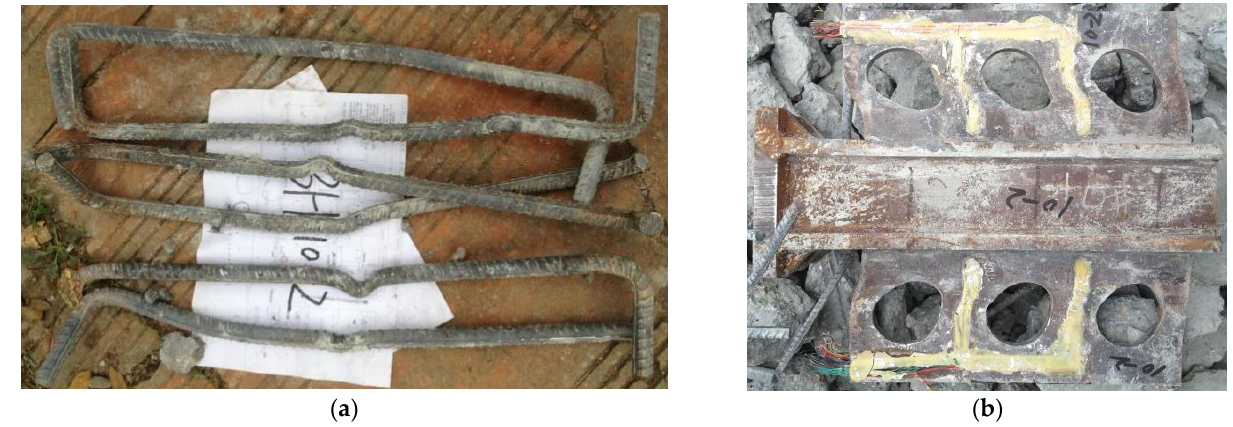
Figure 15. Rib plate and reinforcement of the BH 10-2 specimen after the test: ( a ) Deformation form of reinforcement; ( b ) Deformation form of rib plate.